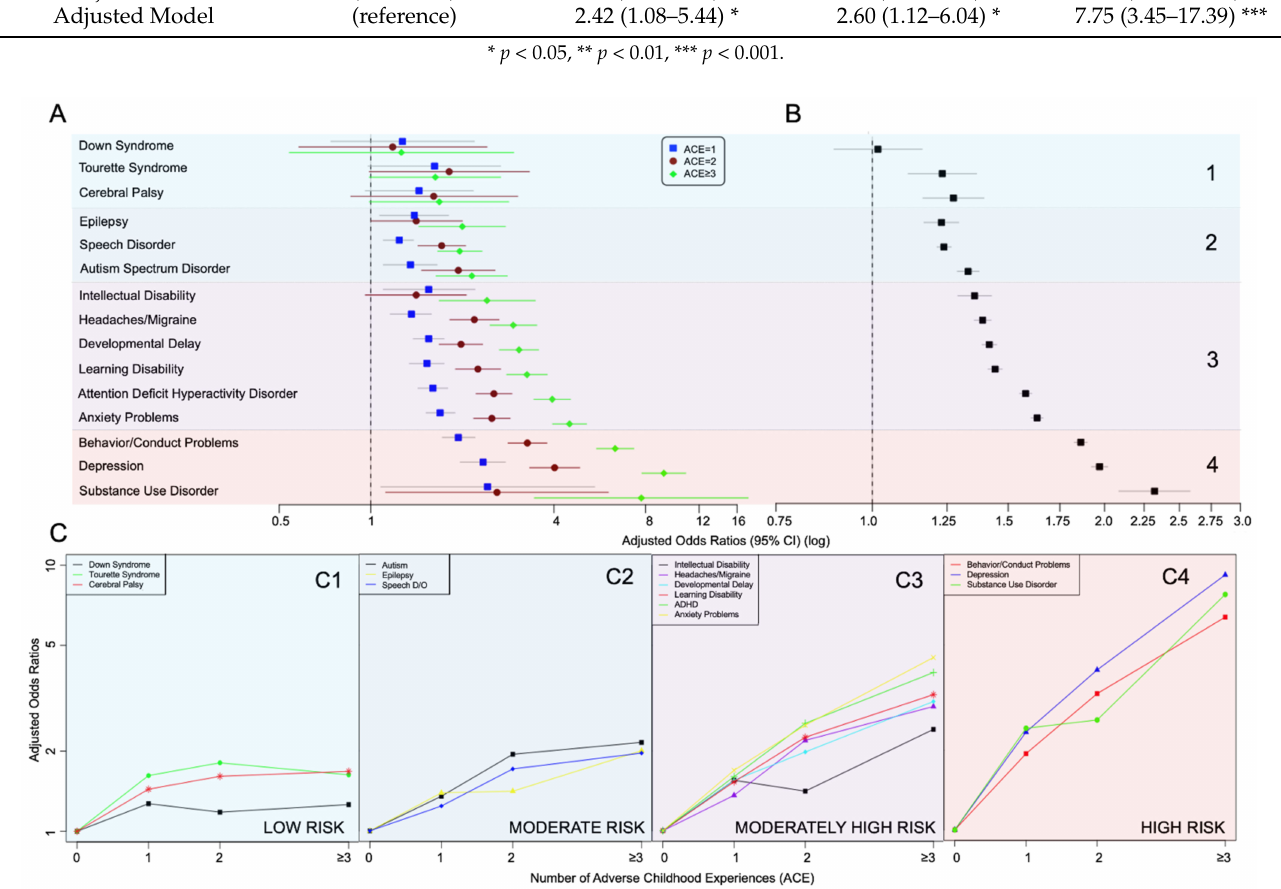
Figure 1. ( A ) Rank order of point estimate associations between household challenge ACEs and adjusted odds ratios of physical, developmental and behavioral health conditions surveyed in the National Survey of Child Health. ( B ) Associations between household challenge ACEs and odds ratios of behavioral and developmental health conditions surveyed in the National Survey of Child Health. ( C ) Dose-response natures of household challenge ACEs and odds ratio